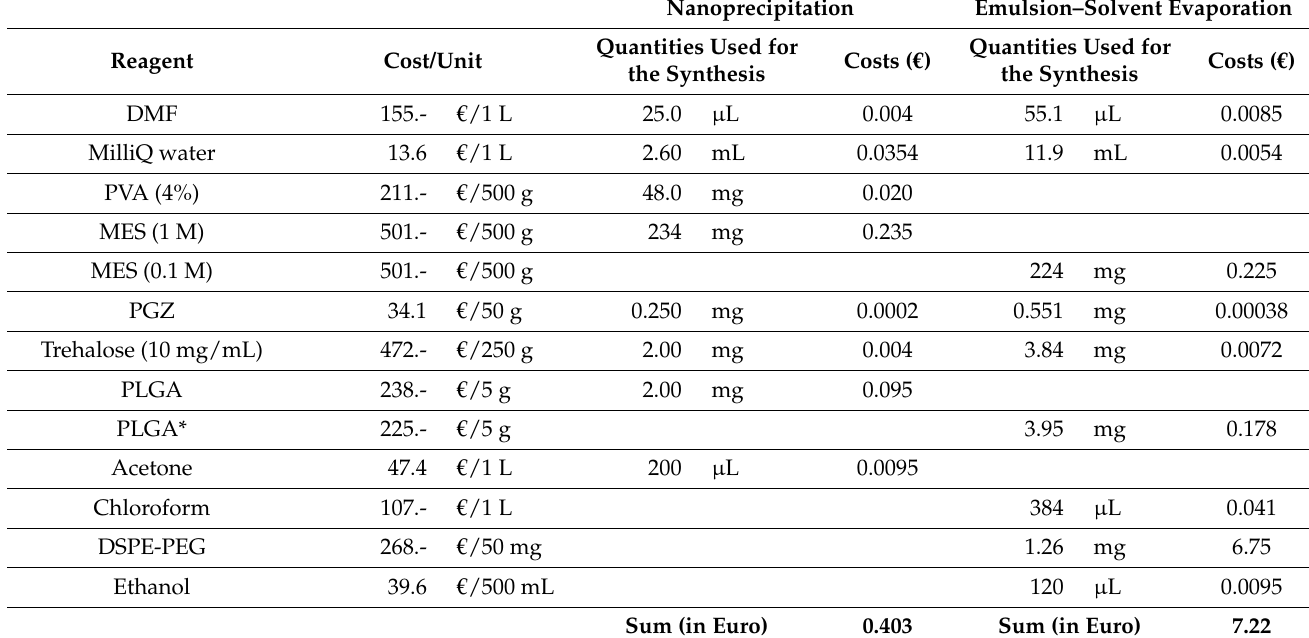
Table 2. Cost estimation summary for encapsulation of PGZ (0.145 mg) within PLGA nanoparticles via nanoprecipitation or emulsion–solvent evaporation methods. Costs reference period: 2021.